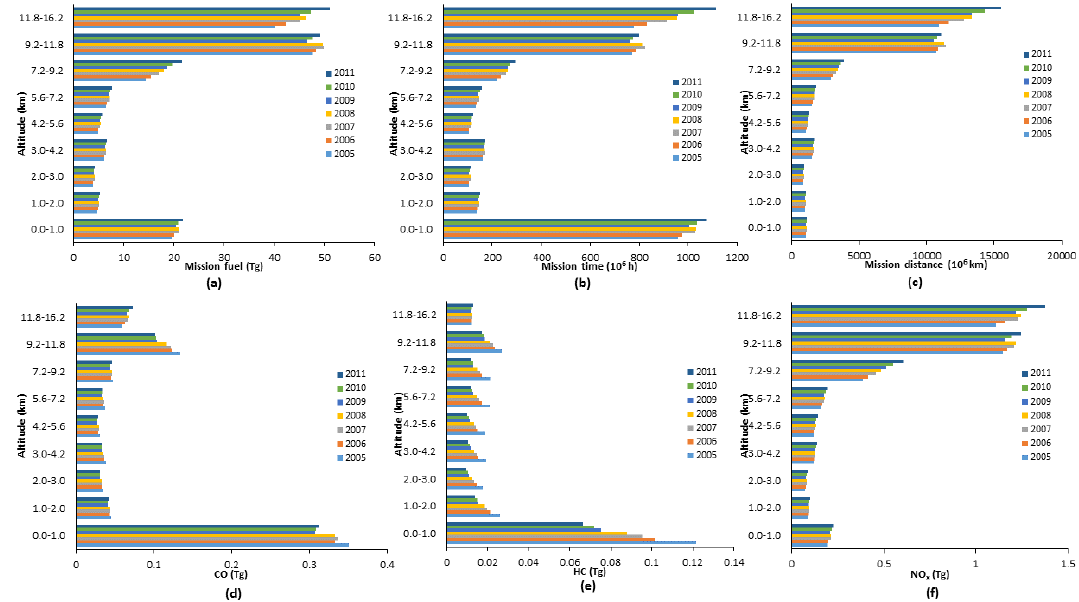
Figure 2. Vertical distribution of the global total ( a ) mission fuel burn, ( b ) mission time, ( c ) mission distance, ( d ) CO emissions, ( e ) HC emissions, and ( f ) NO x emissions during 2005–2011